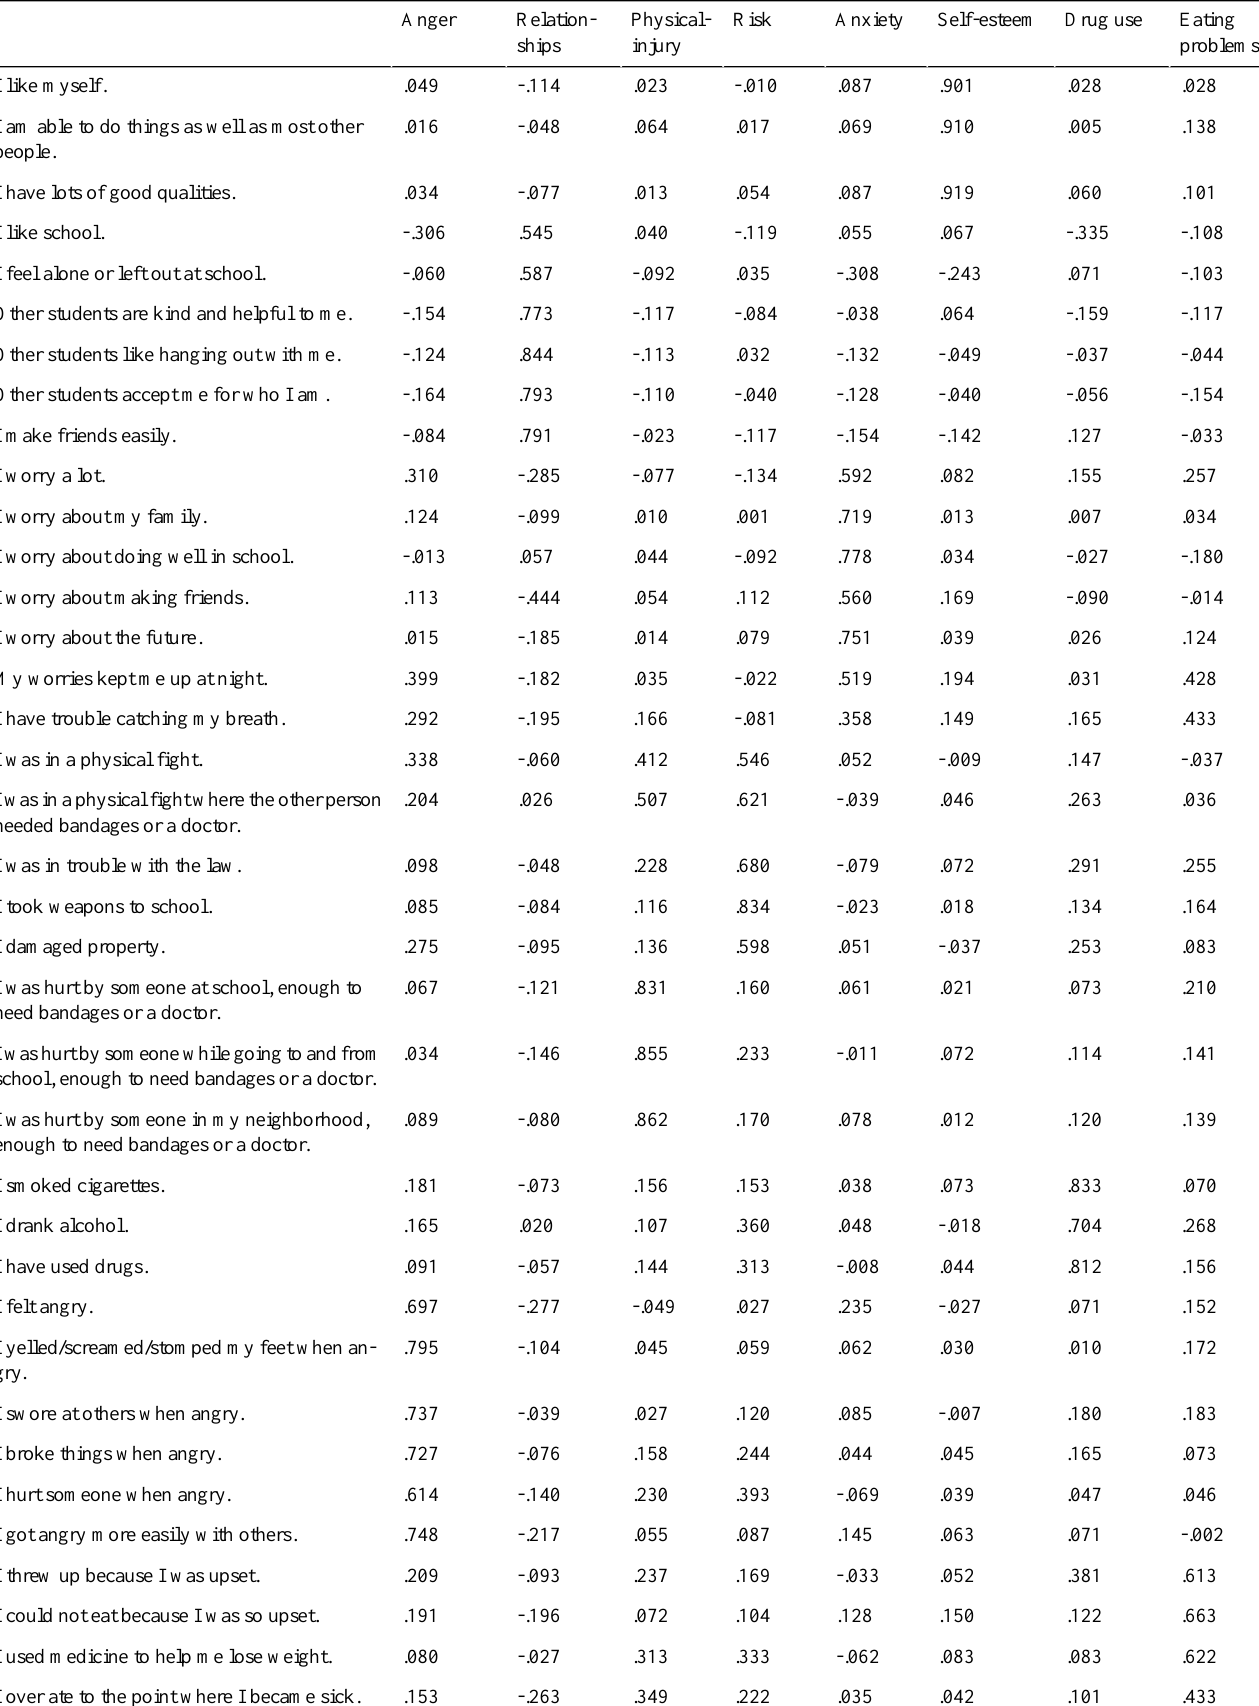
Eating problemsDrug useSelf-esteemAnxietyRiskPhysical- injuryRelation- shipsAnger